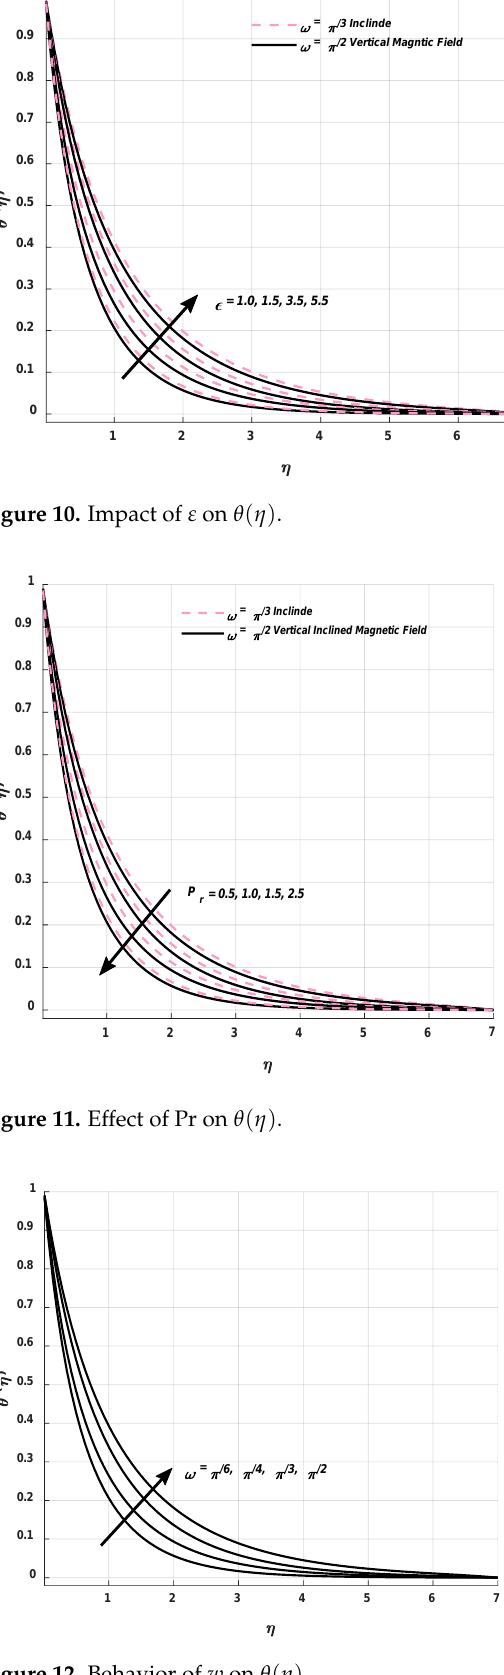
Figure 12. Behavior of w on